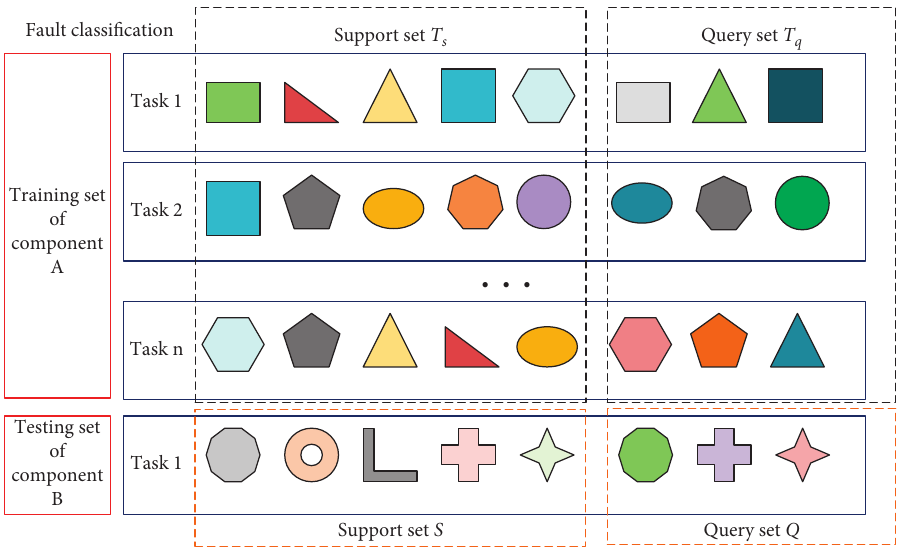
Figure 2: Problem description of cross components fault diagnosis.